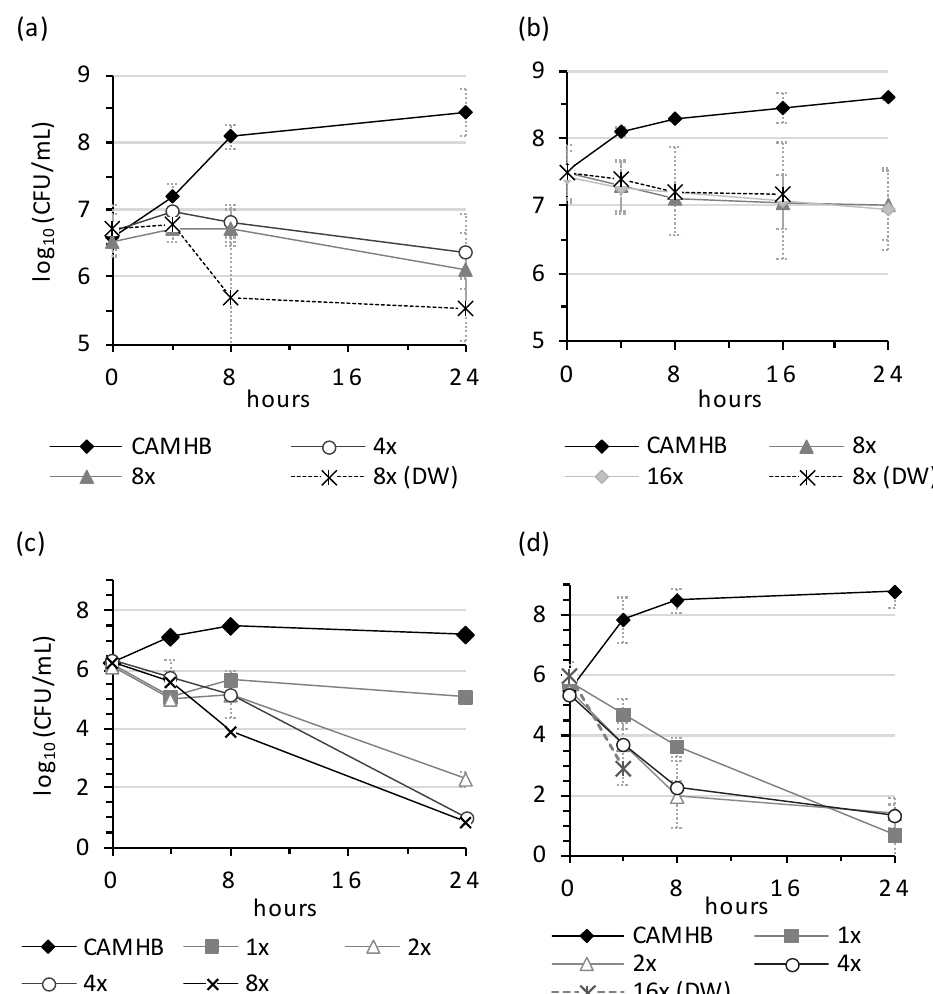
Figure 2. Bactericidal rates of NPBD for Gram-positive species. ( a ) Staphylococcus aureus ATCC29213, ( b ) Corynebacterium xerosis RMIT53/5, ( c ) Enterococcus faecalis ATCC29212, ( d ) Bacillus subtilis ATCC6633 in CAMHB or distilled water (DW). NPBD was tested at multiples of the MICi in CAMHB with 1% v / v DMSO. Limit of detection <10 cfu. Assays repeated 2–4 times and average viable counts reported.